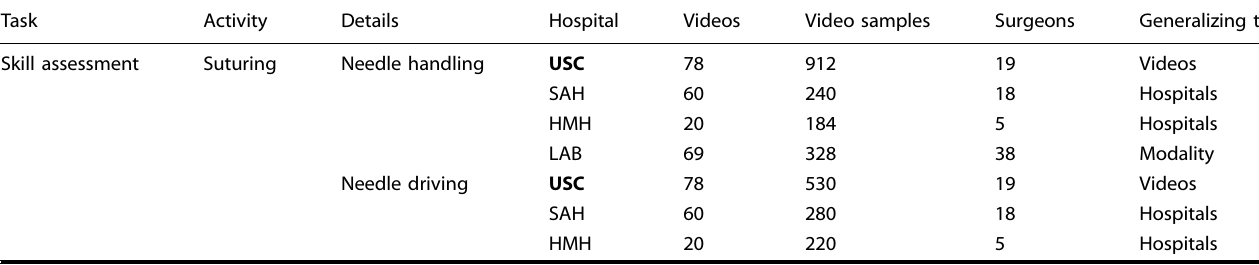
Table 2. Total number of videos and video samples associated with each of the hospitals and tasks.